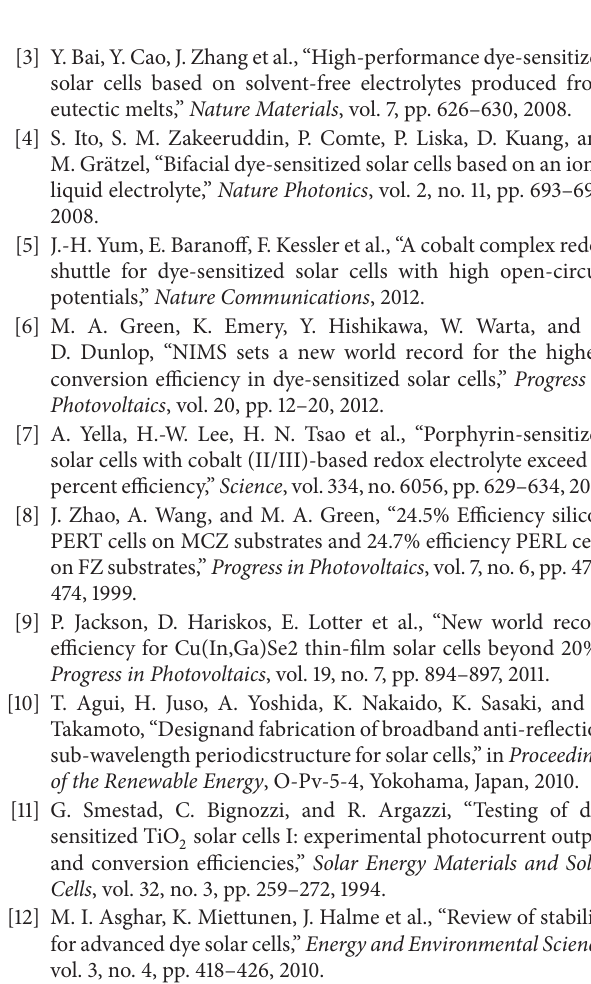
Figure 7: FT-IR measurements of double-bond-edged dye-adsorbed TiO 2 nanoparticles before and after annealing; (a) 2700–3100 cm −1 and (b) 1200–1900cm −1